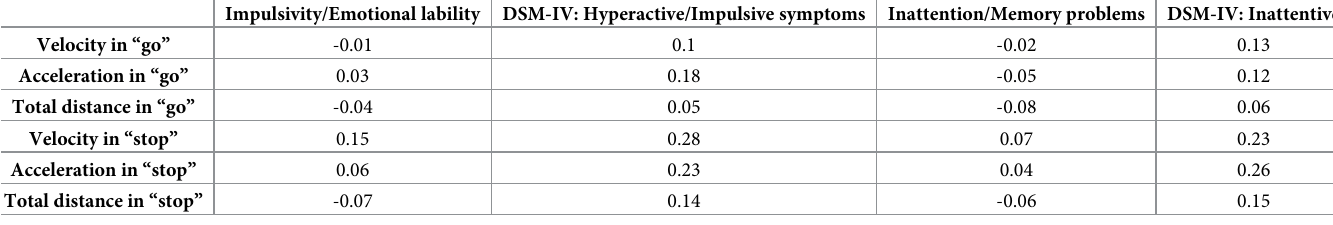
Table 16. Values of Spearman’s ρ for correlations between mouse measures and impulsivity/inattention measures at 10%